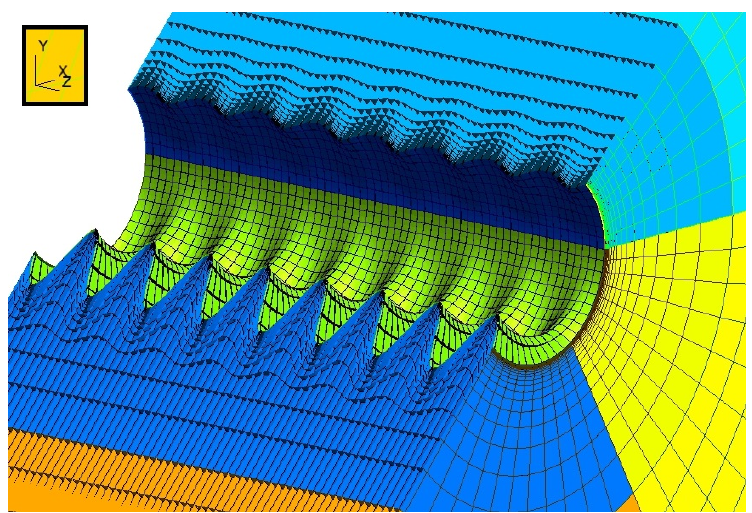
Figure 5. Cross-sectional view of a mesh showing the mapping pattern for λ = 0.375 D m , and wavi- ness amplitude 11% (the line of contact between the green and dark blue regions is the cylinder’s trailing